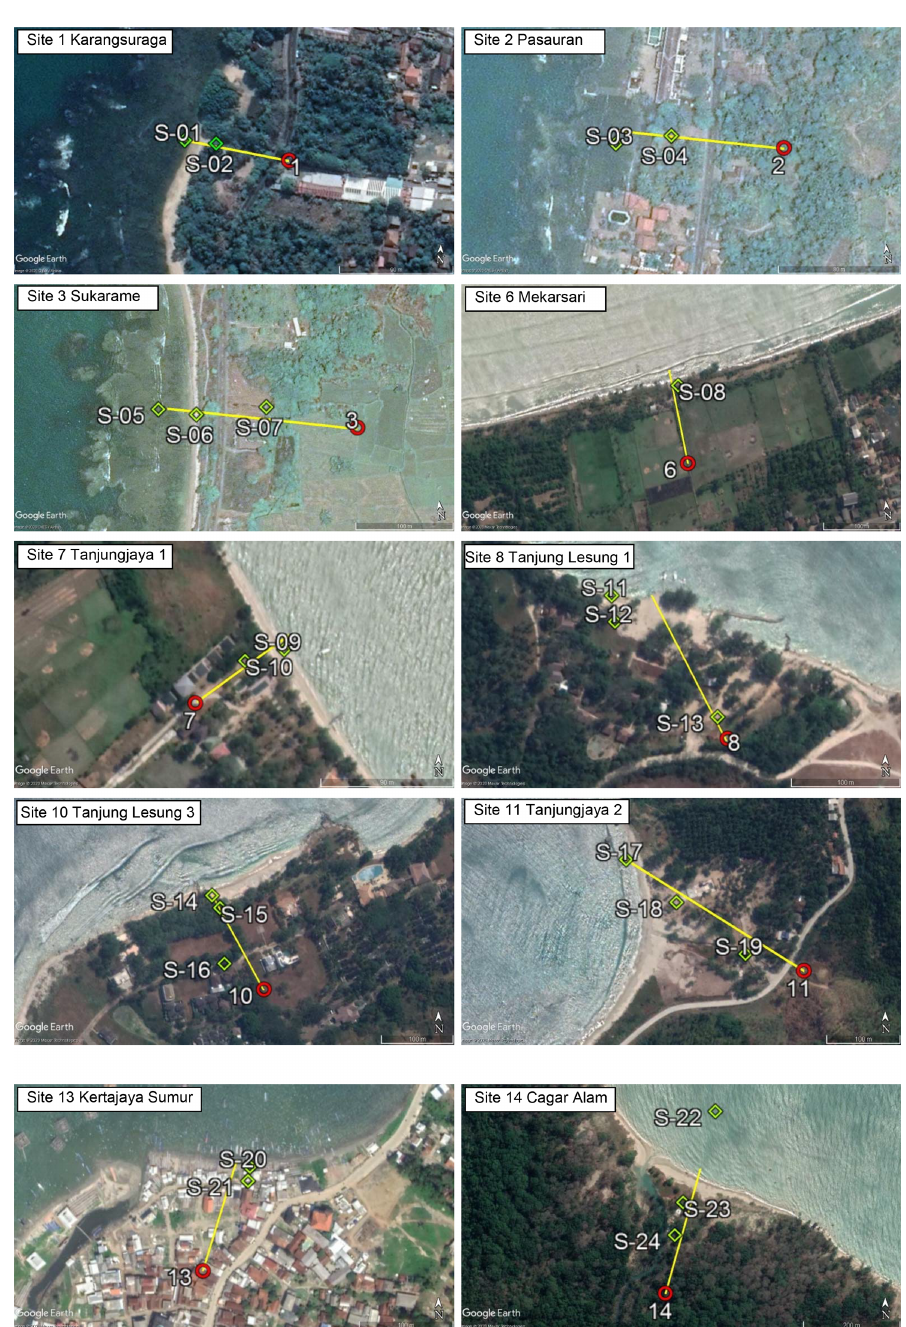
Figure 2. Aerial photographs from © Google Earth of transects including highest run-up point and deposit